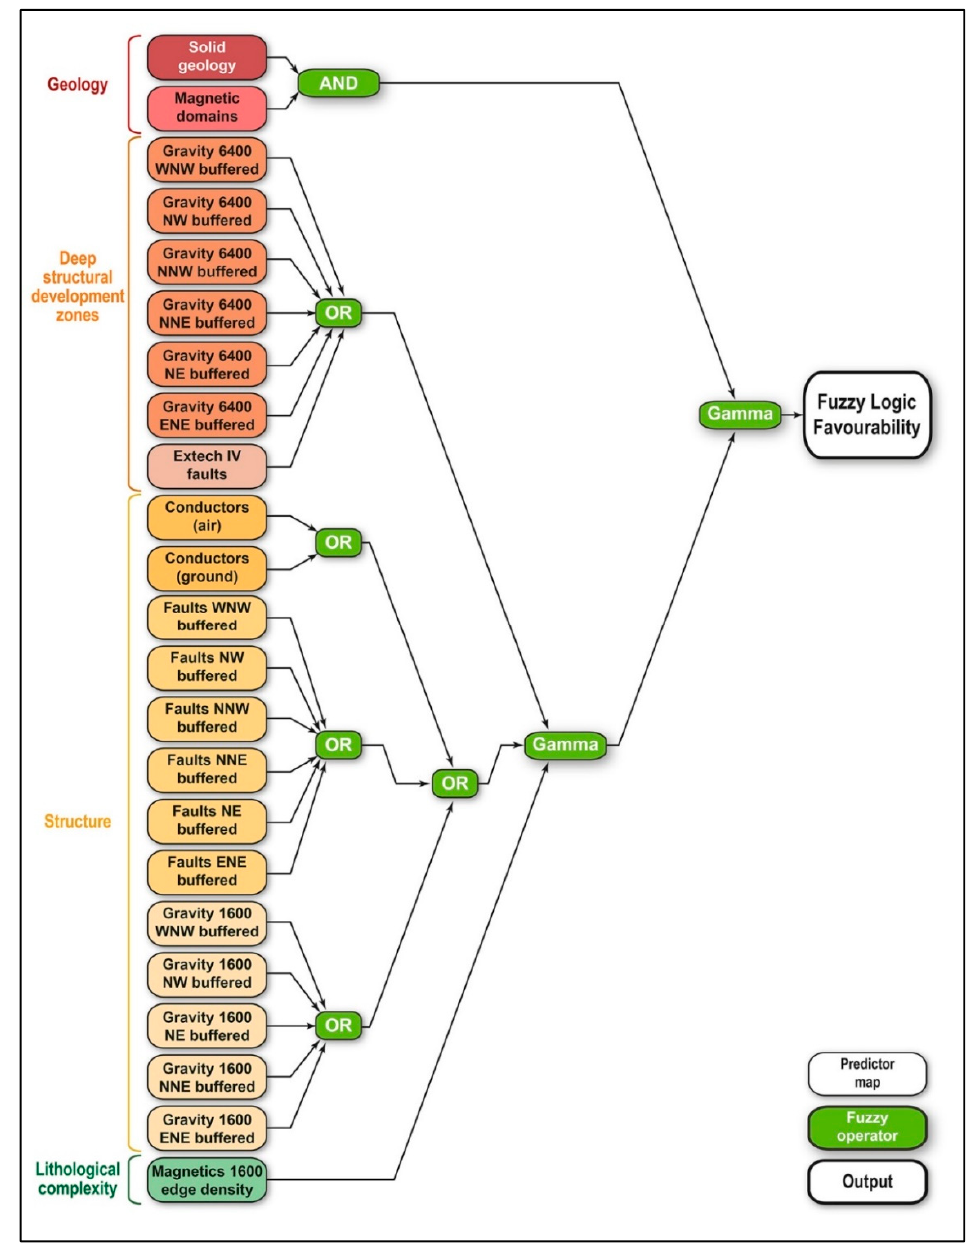
Figure 11. Athabasca Basin inference network. Predictor maps are grouped and shaded on the basis of recognition criteria class. Fuzzy logic operators are used to combine weighted and rasterised predictors via a series of intermediate steps to produce the final fuzzy logic favourability map.